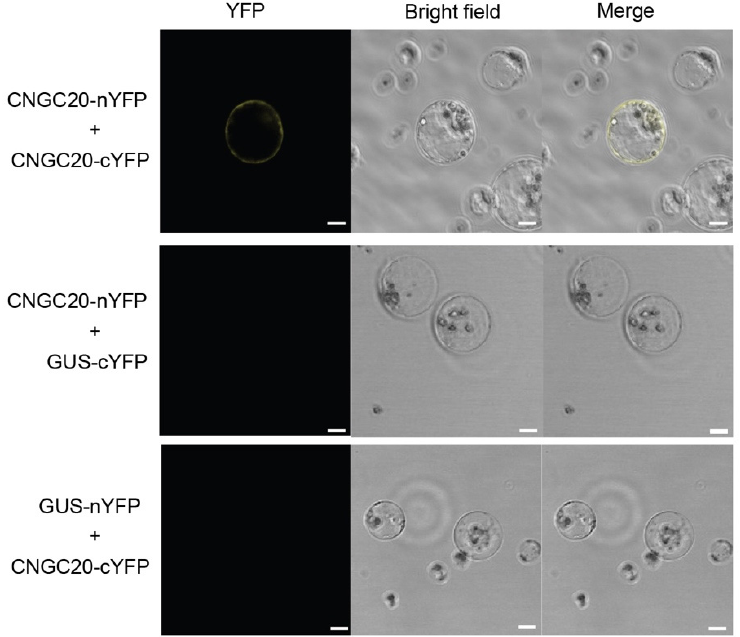
Figure 6. Bimolecular fluorescence complementation (BiFC) assay of CNGC20 self-association in banana protoplasts. Arabidopsis CNGC20-nYFP and CNGC20-cYFP were transiently co-expressed in the banana protoplasts. The co-expressions of CNGC20-nYFP and GUS-cYFP, and GUS-nYFP and CNGC20-cYFP were included as negative controls. Images were captured using a confocal microscope 12 h after transformation. Bars = 10 μ m.